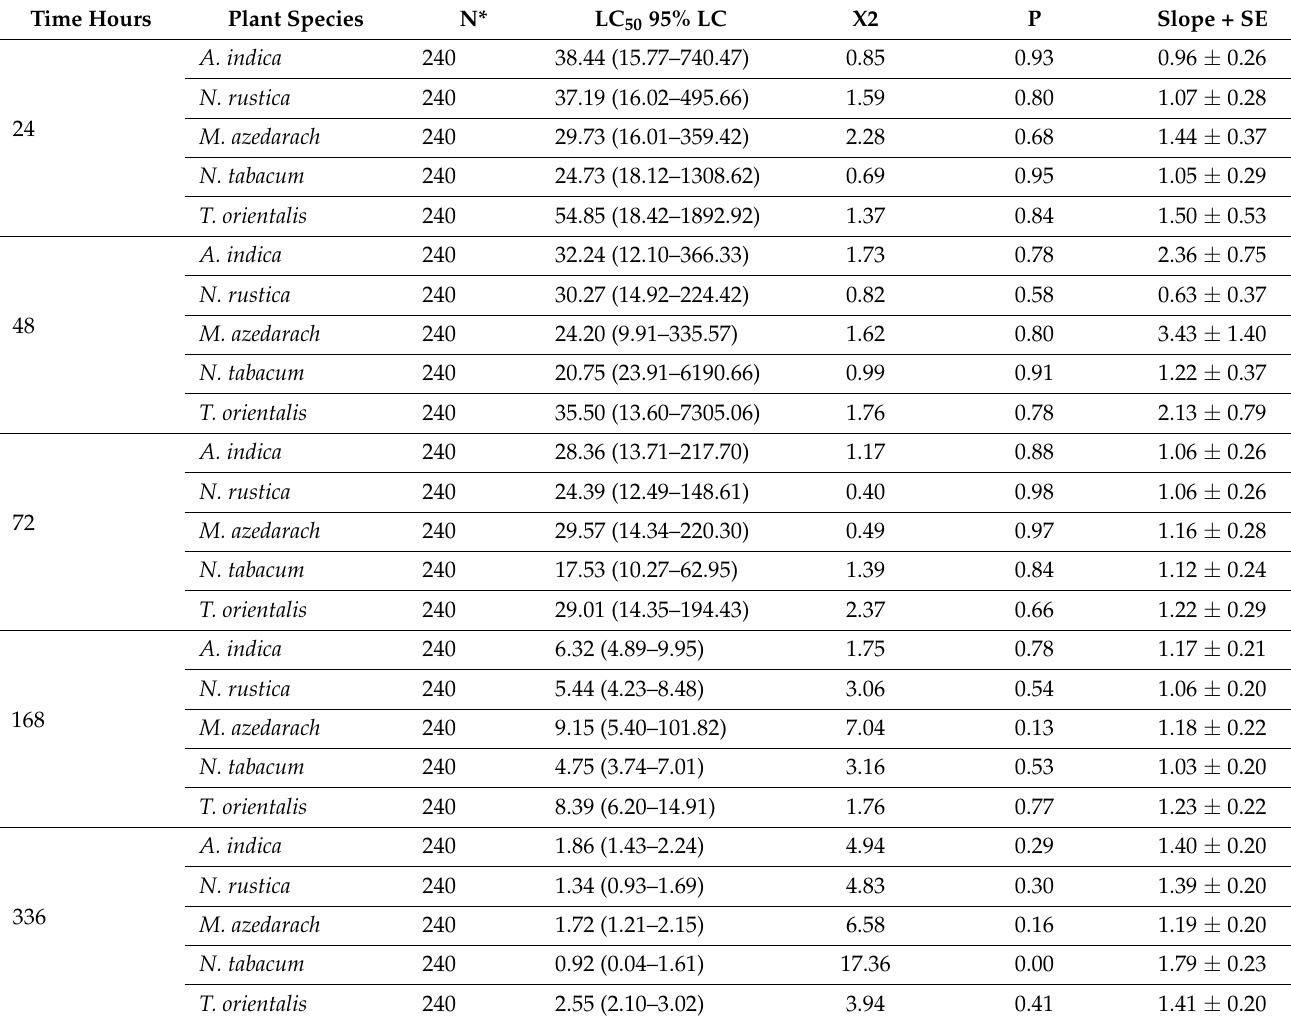
Table 4. Mortality of C. maculatus exposed to aqueous extracts for 24, 48, 72, 168 and 336